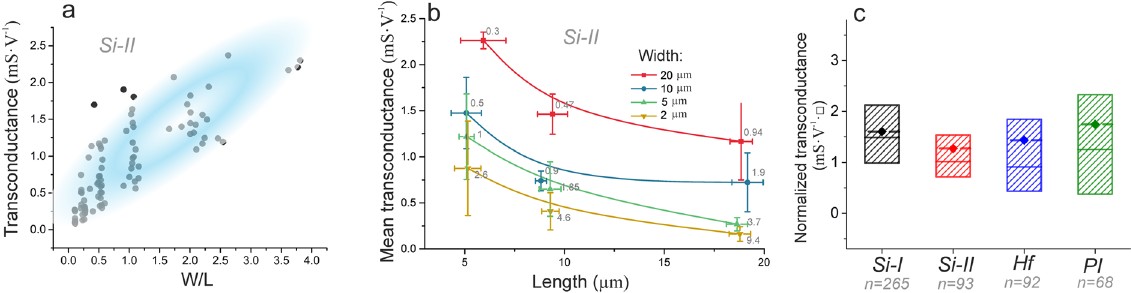
Figure 4. ( a ) The scatter plot (gray points) of the transconductance values for 93 devices from wafer Si-II and a blue oval showing a general linear trend. ( b ) The mean and SD values of the GFET transconductances on wafer Si-II, and their dependency on length while keeping the width constant. Numbers near each data point represent the number of squares. ( c ) The linear fitted curves of the four wafers; black: Si-I, red: Si-II, blue: Hf, green: PI. ( d ) The statistical distribution of the normalised transconductance of the four wafers; black: Si-I, red: Si-II, blue: Hf, green: PI. The box is 25% to 75%, the dashed line with diamond shows mean value and the solid line the 50% value.